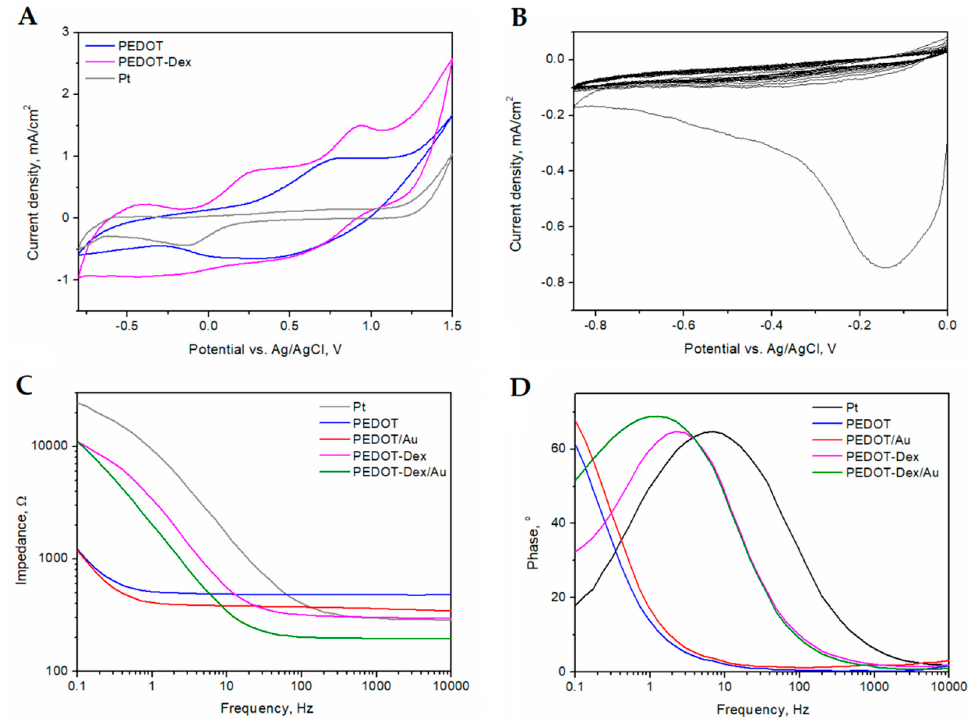
Figure 1. Electrochemical properties of poly(3,4-ethylenedioxythiphene) (PEDOT)-functionalized Pt electrodes. ( A ) Cyclic voltammetric (CV) curves of the final cycles of the electropolymerization process of EDOT (15 mM) formed in 1 × phosphate buffered saline (PBS) or in 1 × PBS in the presence of 10 mM Dex, together with a CV of a bare Pt electrode. ( B ) CV curves of the process of gold deposition from 2 mM HAuCl 4 aqueous solution in 1 × PBS. ( C ) Bode plot expression of impedance modulus and ( D ) Bode plot expression of the phase angle of PEDOT, PEDOT/Au, PEDOT-Dex, PEDOT-Dex/Au and a bare Pt electrode, collected in 1 × PBS.